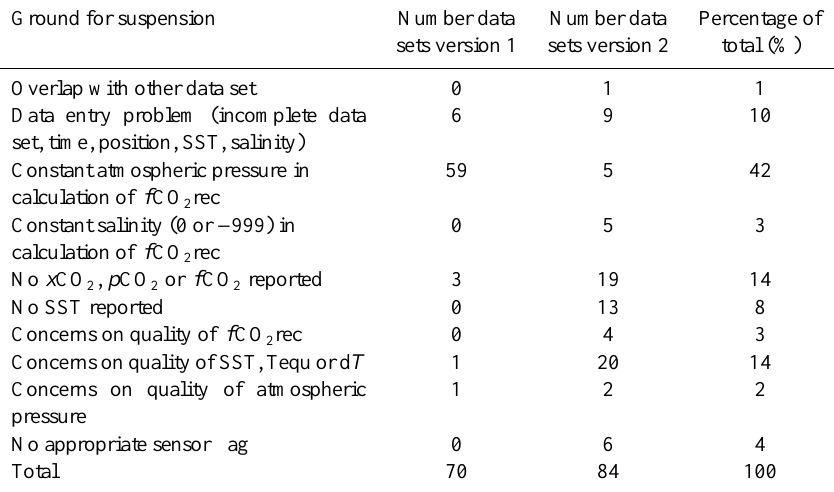
Table 10. Grounds for suspension of data sets from SOCAT version 2. A distinction is made between data sets previously included in version 1 and new data sets in version 2. Abbreviations are SST for sea surface temperature, Tequ for equilibrator temperature and dT for the di ff erence between the equilibrator temperature and the sea surface